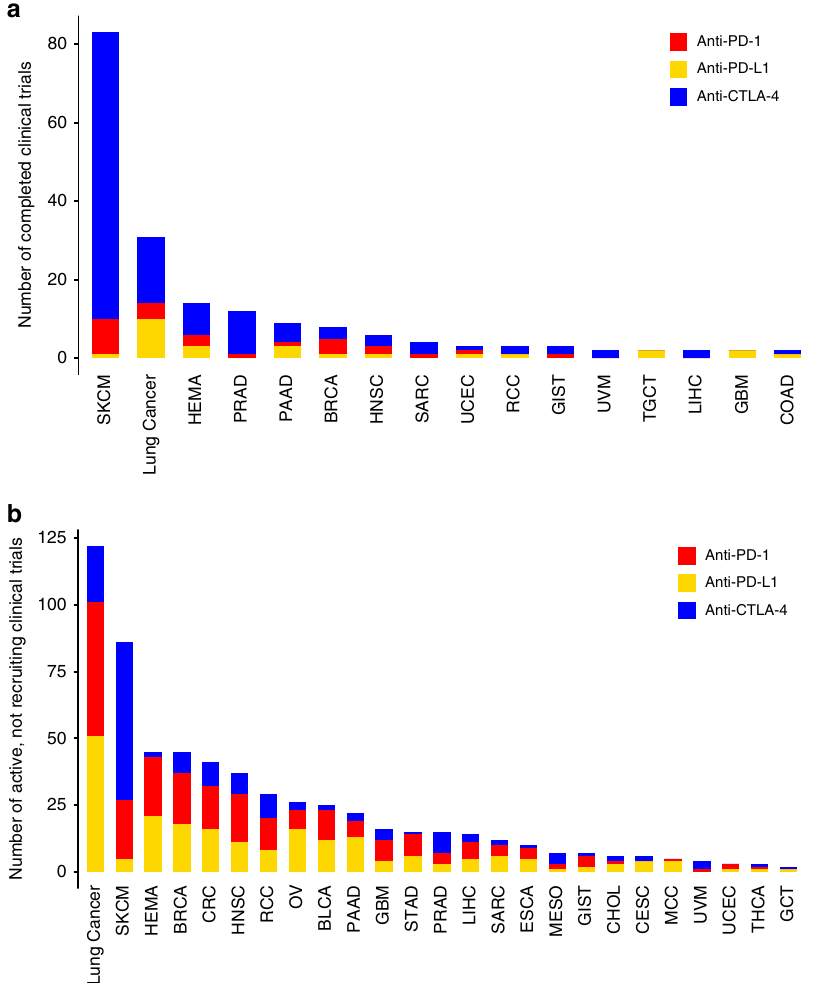
Fig. 4 Immunotherapy clinical trials across cancer types. Number of ICB clinical trials for anti-PD-1/PD-L1 and anti-CTLA-4 across cancer types as of April 16, 2019, with status of a completed and b active, not including molecular pro fi ling data in future clinical trials to understand gender effects on immunotherapy.